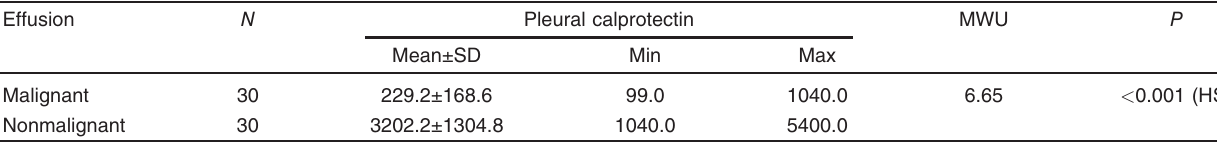
Table 1 Statistical analysis of pleural calprotectin level among the two studied